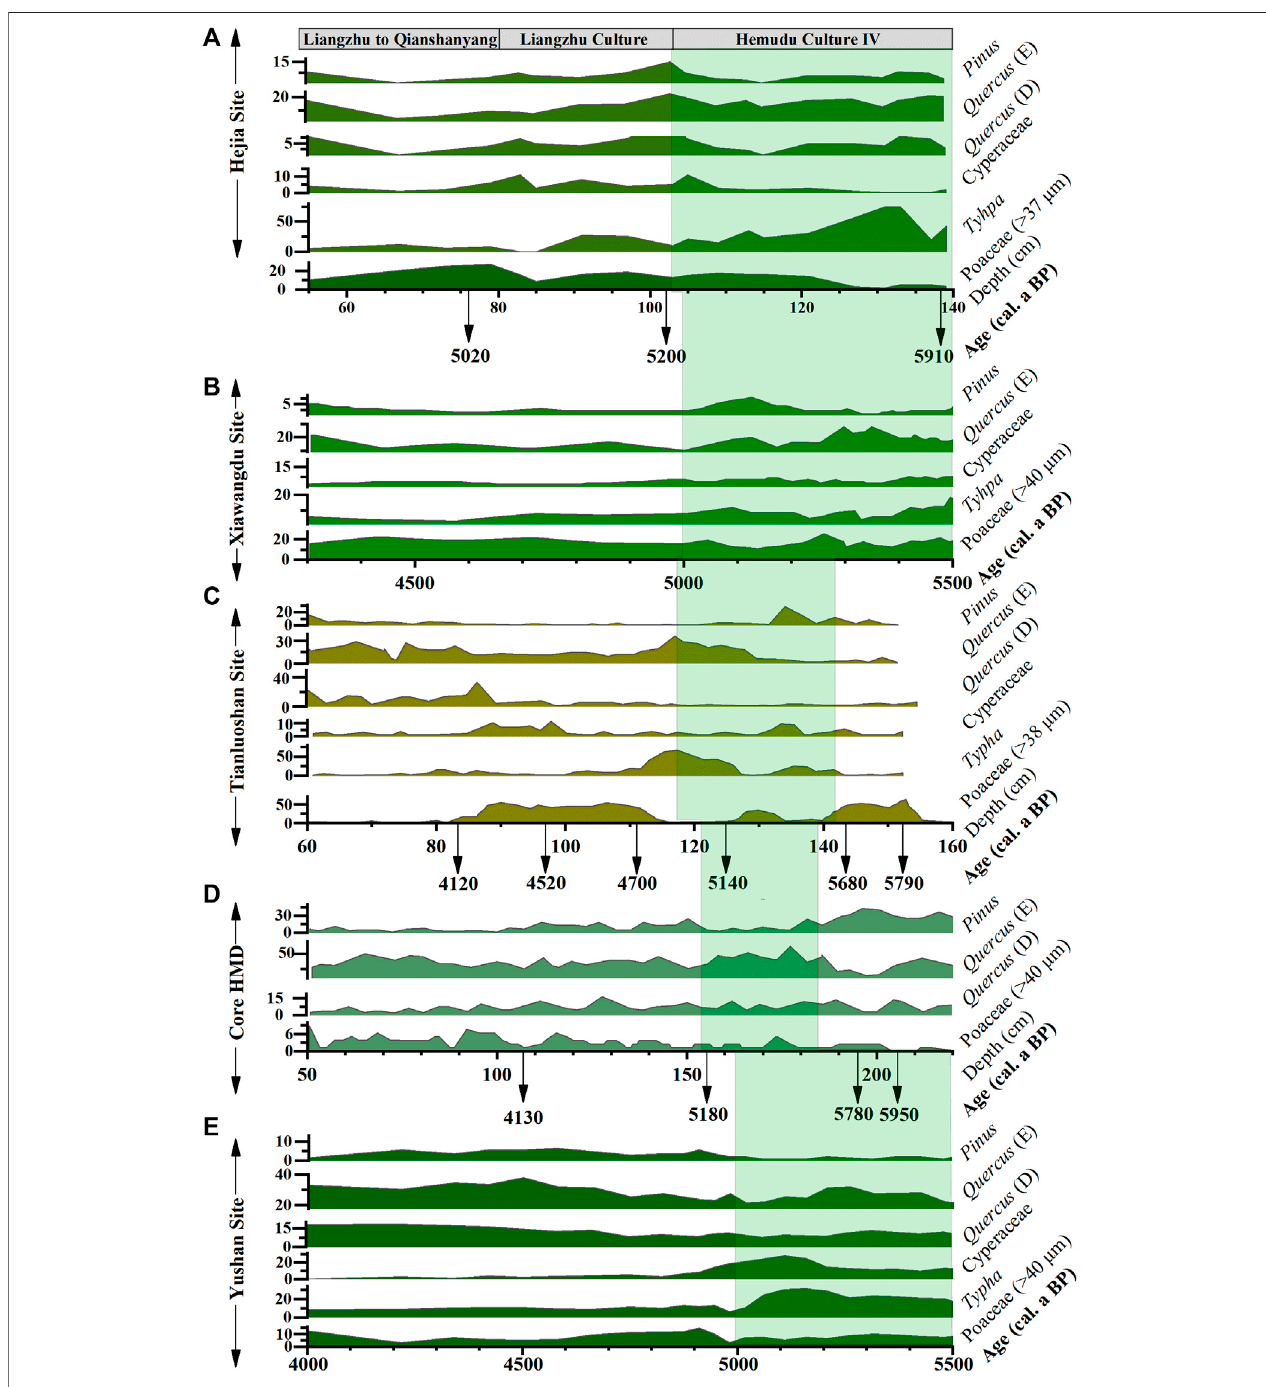
FIGURE5| Pollenrecord comparisonsfromthenearbysitesandcore. (A) theHejiaSite(thisstudy), (B) theXiawangduSite(He,etal.,2020a), (C) theTianluoshan Site (Li et al., 2012), (D) HMD sediment core (Liu et al., 2016), and (E) the Yushan Site (He et al., 2018). Hemudu Culture IV is displayed in green shadow.